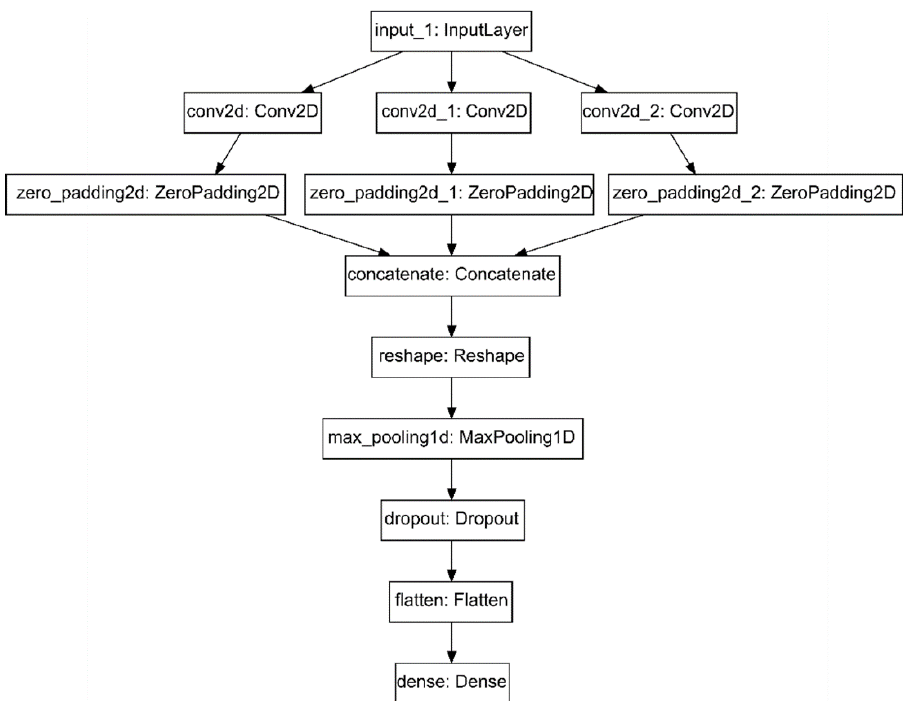
Figure 10. Convolutional Neural Network architecture including flattening layers.